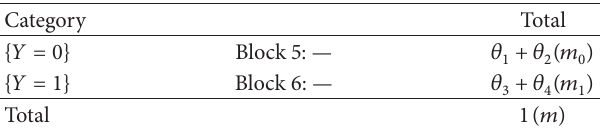
Table4:Cellprobabilitiesandobservedcountsforthesupplemental